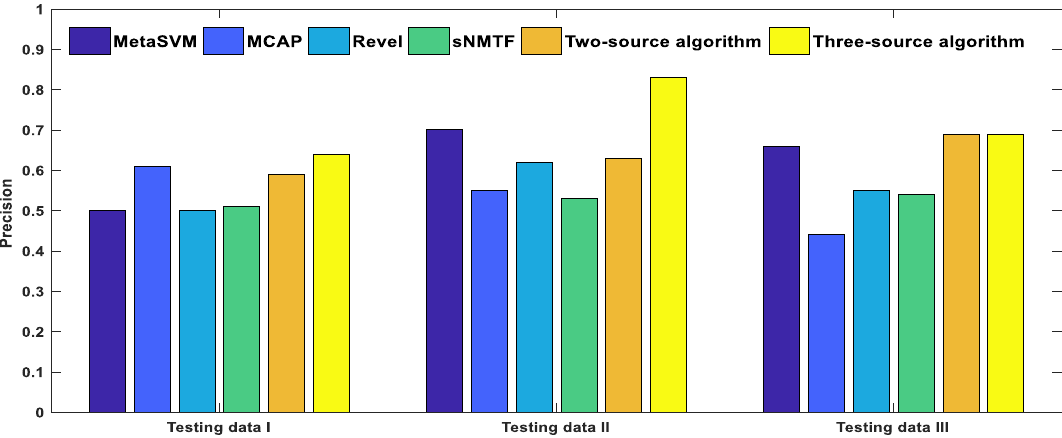
Figure 5. The bar charts represented the precision values of the six different deleteriousness prediction tools for the variants positioned on nonpathogenic genes over three testing datasets. The figure is created using MATLAB version 7.0.1 (Math Software Co., Math Works,